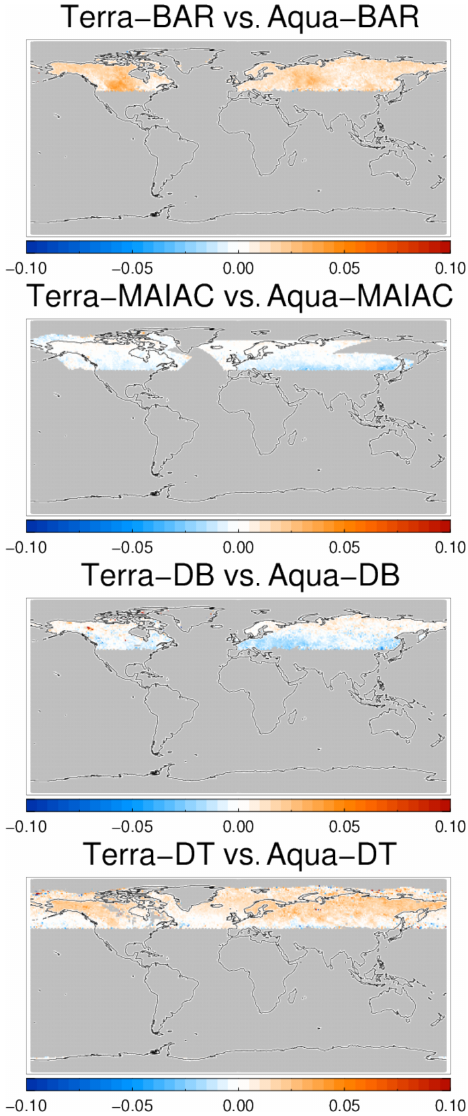
Figure 15. Global maps of the 3-year averaged difference in AOD for products based on the same algorithm and either Aqua and Terra satellites. Products were collocated pair-wise within